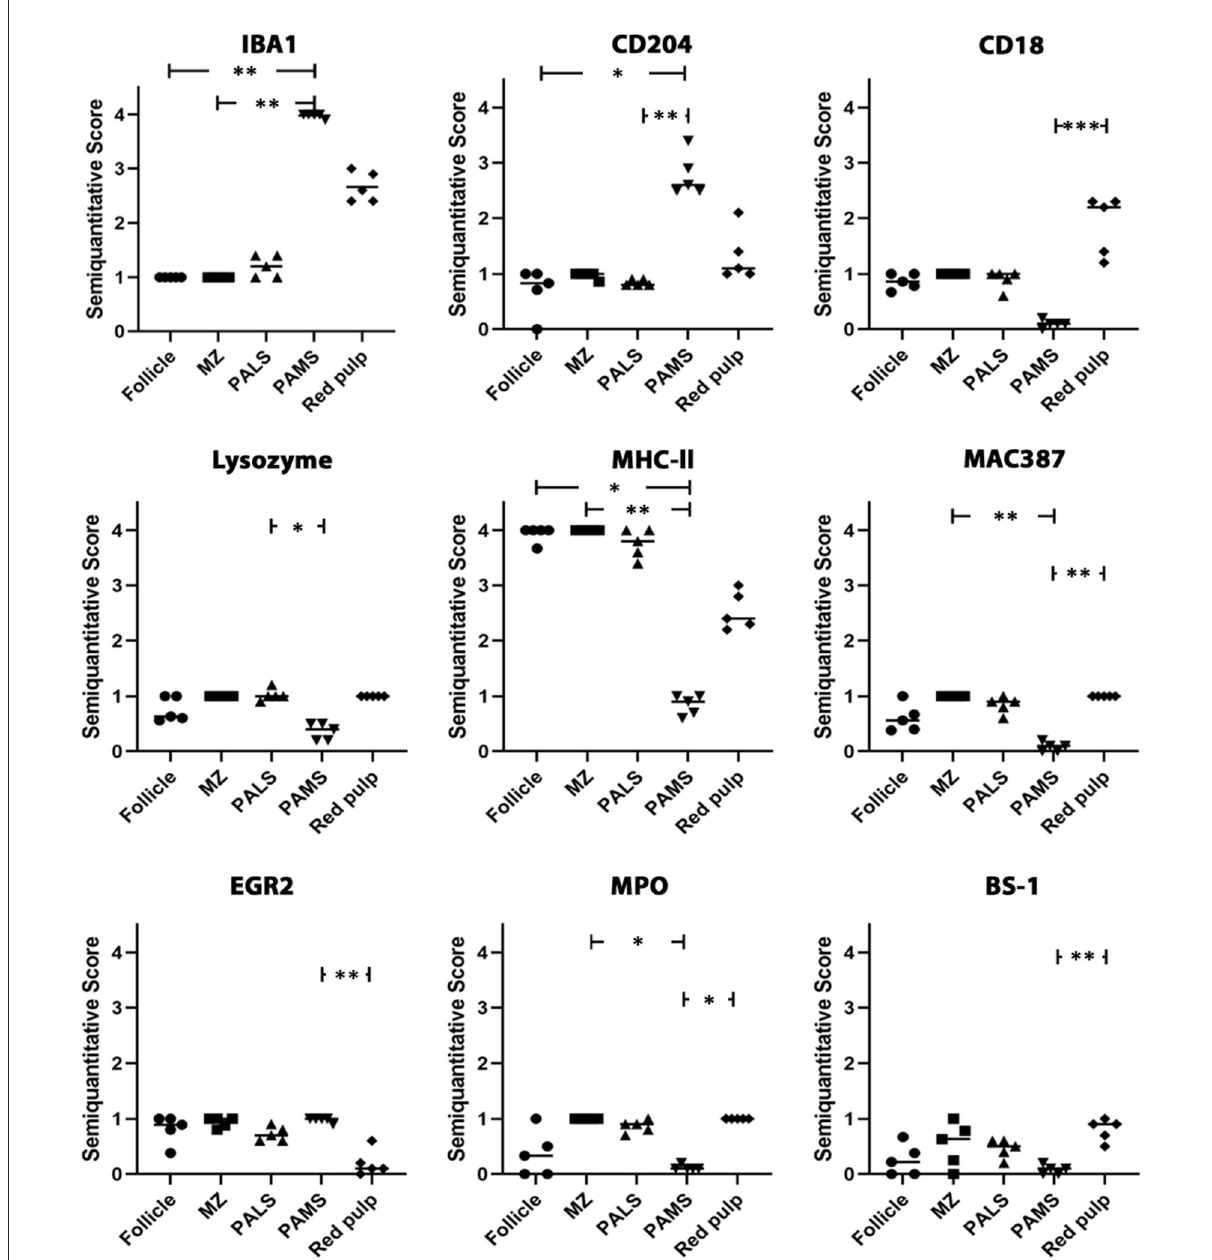
FIGURE7 Analysis of IBA1, CD204, CD18, lysozyme, MHC-II, MAC387, EGR2, myeloperoxidase (MPO) and BS-1 expression in the canine spleen. The white matter of the spleen including follicles, marginal zone (MZ) and periarteriolar lymphocytic sheath (PALS) contains abundant cells expressing MHC-II, whereas cells expressing other markers are rare. The majority of cells in the periarteriolar macrophage sheath (PAMS) are positive for IBA1 and CD204 but negative for other markers. Several cells in the red pulp of the spleen express IBA1, CD204, CD18 and/or MHC-II, whereas only few cells express other markers. Scatter plots of semiquantitative scores (0 = 0%; 1 = 1–25%; 2 = 26–50%; 3 = 51–75%; 4 = 76–100% positive cells). The bars indicate mean values. Friedman-test: * p < 0.05; ** p < 0.01; *** p < 0.001.